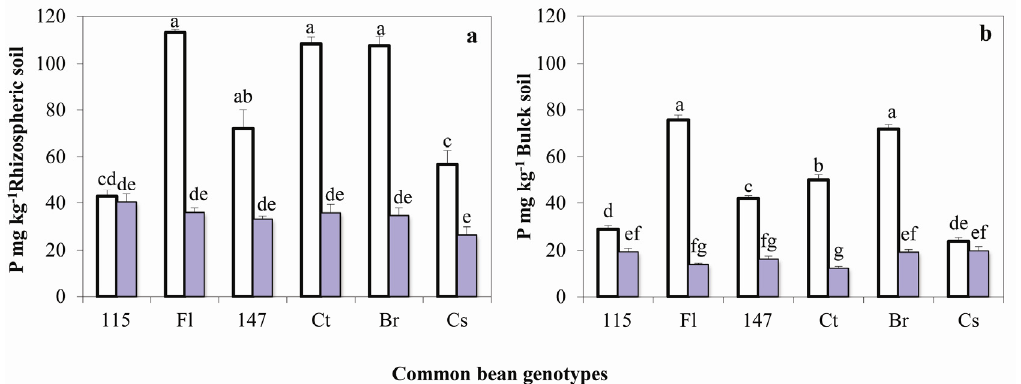
Figure 2. Olsen P in the rhizospheric ( a ) and bulk ( b ) soil of six common bean genotypes grown under sufficient P ( empty bar ) versus low P ( filled bar ) soil. Data are means ± se of six replicates harvested at flowering